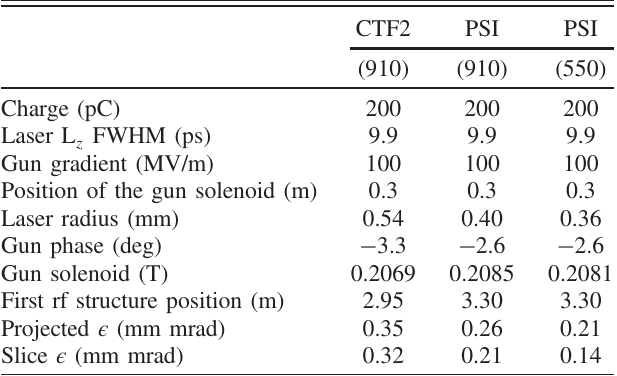
TABLE I. Key parameters of the optimized configurations for the SwissFEL injector assuming the PSI gun for 550 nm = mm and 910 nm = mm compared to the CDR design with the CTF2 gun.